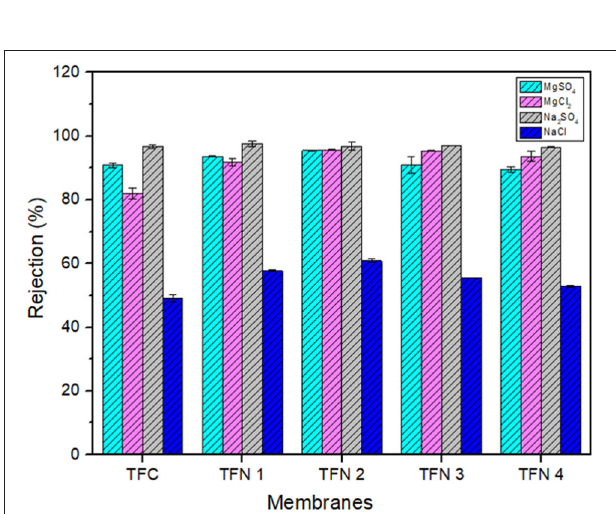
FIGURE 9 | Single salt rejection of TFC and TFN